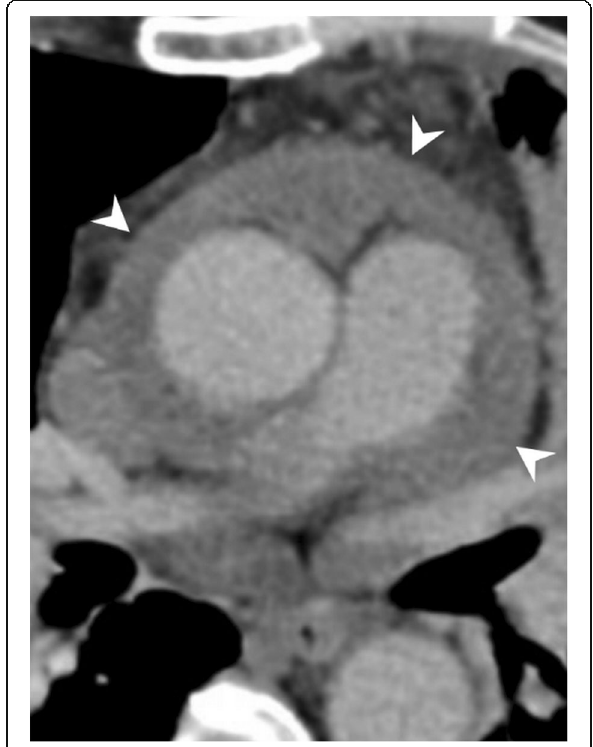
Fig. 7 A 52-year-old woman with breast cancer receiving radiotherapy for treatment. Axial contrast-enhanced CT image reveals pericardial effusion with increased density compatible with hemopericardium (arrowheads)